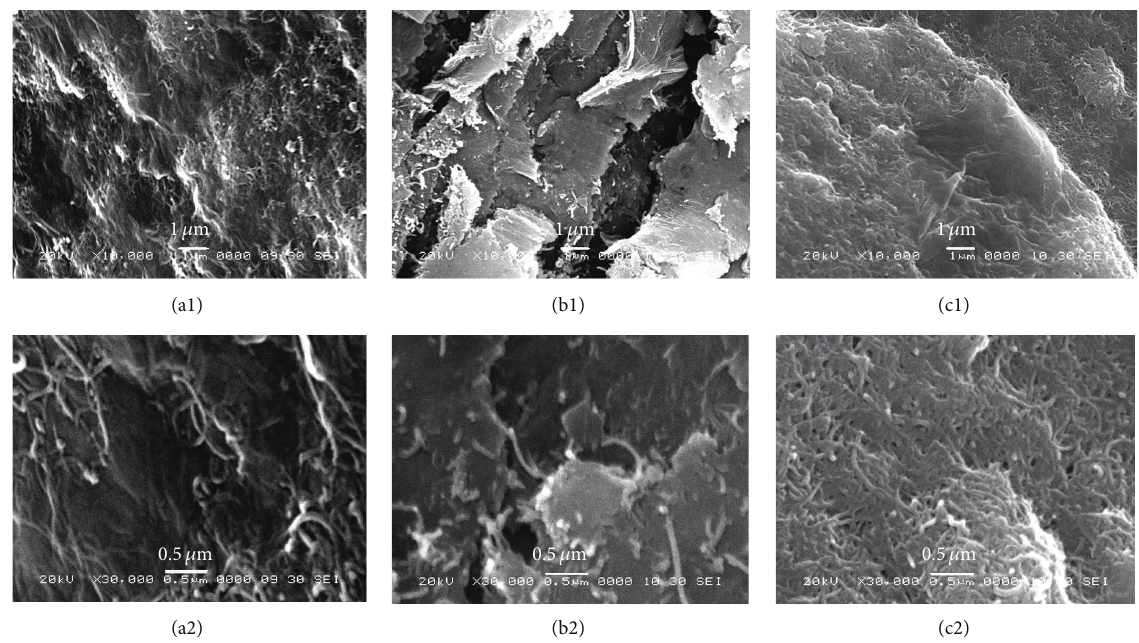
Figure 6: SEM micrographs of G-MWCNTs 3: 1 (a1, a2), G-MWCNTs 1: 1 (b1, b2), and 1: 3 (c1, c2), respectively.